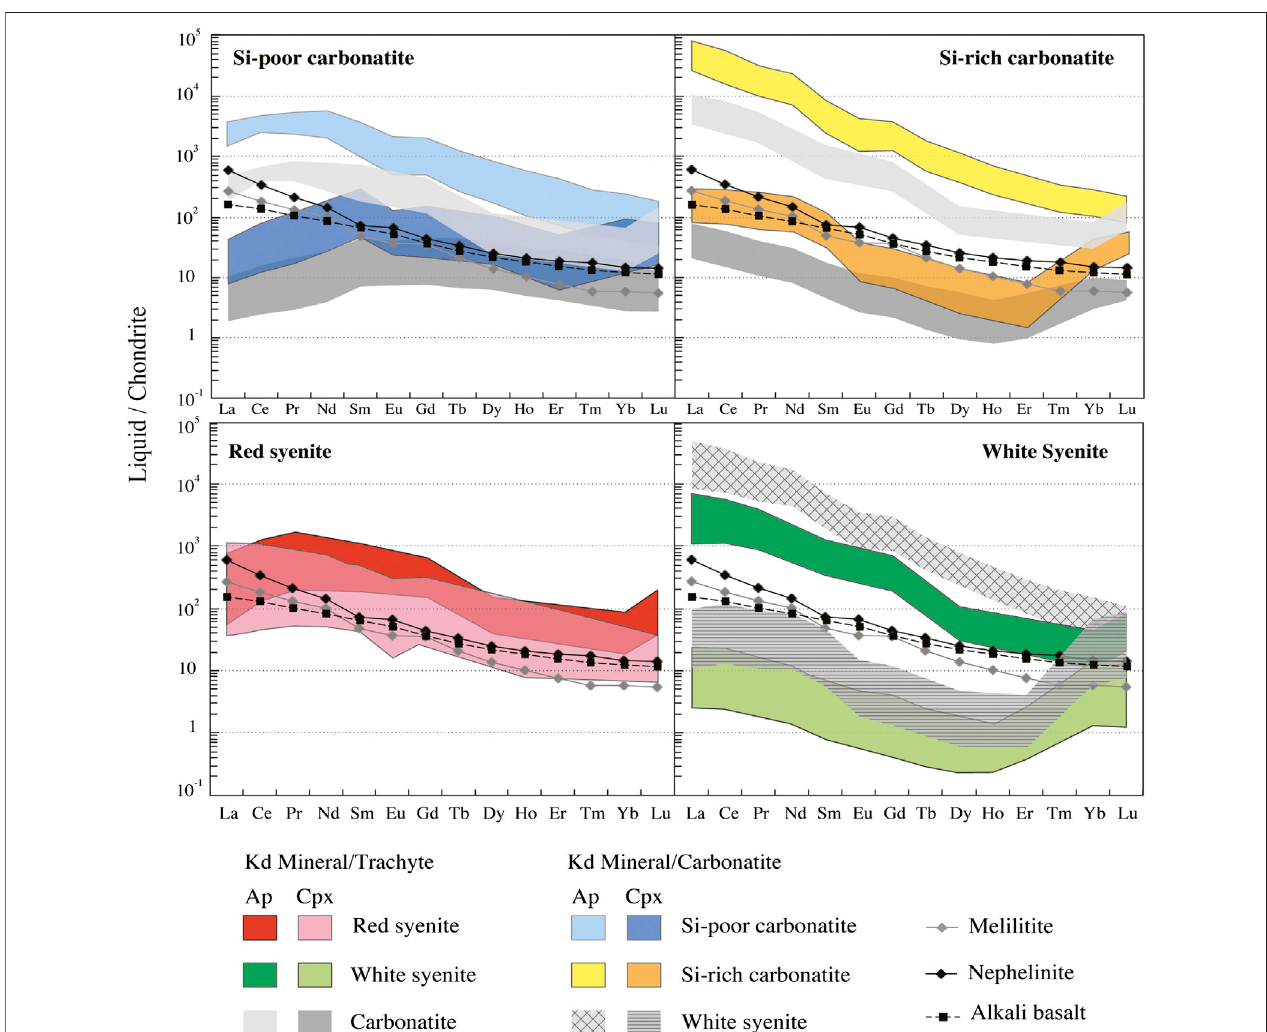
FIGURE 12 | Chondrite normalized REE contents of recalculated apatite and clinopyroxene equilibrium liquids from Ihouhaouene carbonatites and associated syenites compared to nephelinite, melilitite, and alkali basalt REE compositions. Chondrite and alkali basalt values are obtained from Sun and McDonough (1989). Hanang nephelinite and Labait melilitite are obtained from Baudouin et al. (2016) and Baudouin and Parat (2020).